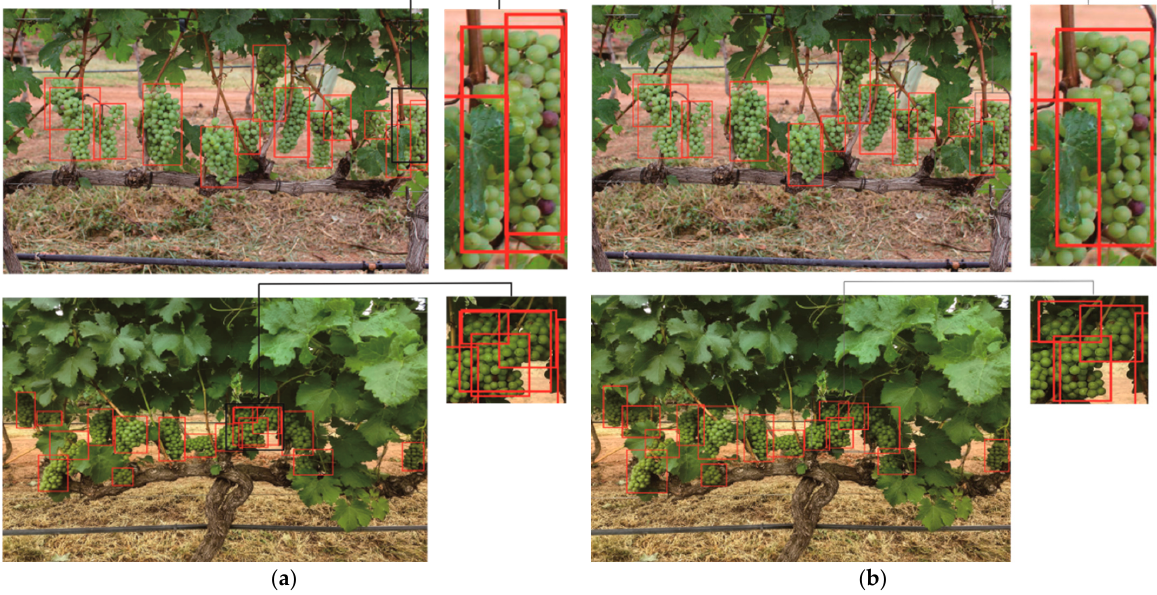
Figure 12. The detection results under different non-maximum suppression algorithms. ( a ) NMS; ( b ) R-NMS.